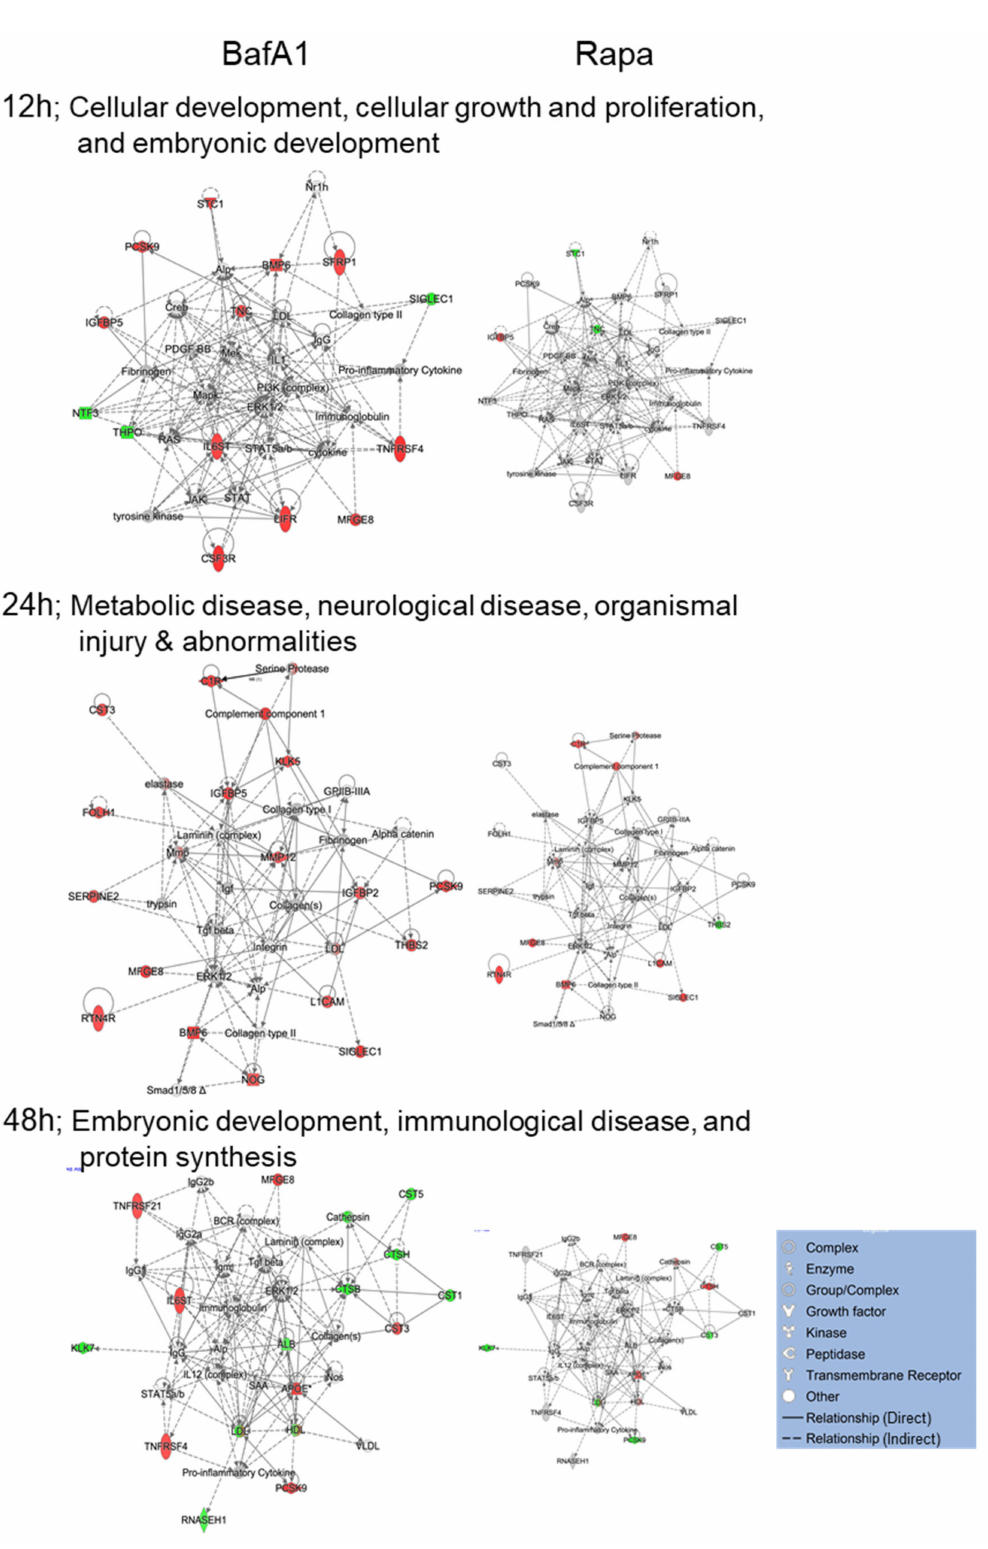
Figure 4. IPA-determined top cellular Networks a ff ected by 2 nM BafilomycinA1 (BafA1). Top BafA1- a ff ected network at each time (left), with 200 nM rapamycin data overlaid (right). The top rapamycin- a ff ected networks are shown in Figure 5. Red proteins are significantly up-regulated; green are down-regulated; grey proteins were not significantly dysregulated; white proteins are part of the network but not covered by the SOMA panel. Protein types indicated in